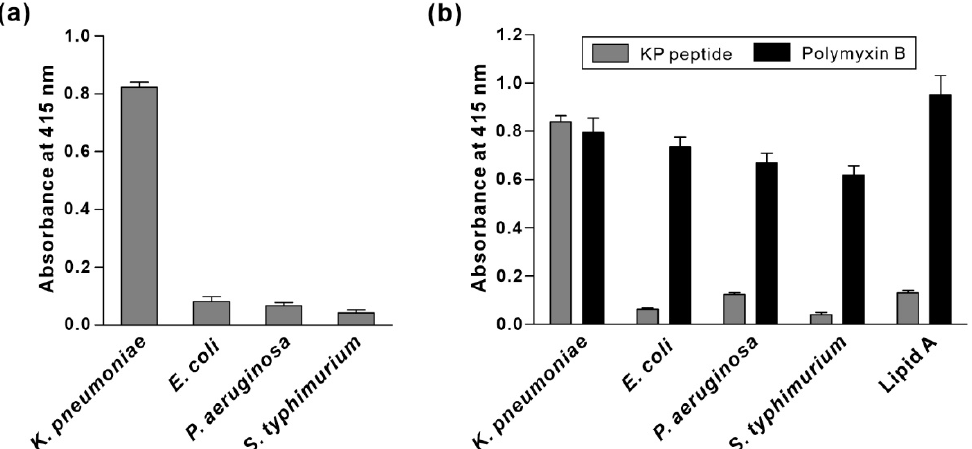
Figure 5. Validation of binding activity of KP peptide to LPS. The binding of KP peptide to LPS from K. pneumoniae and their cross binding to LPS from the other Gram-negative bacteria were determined by peptide-binding ELISA. Extracted LPS ( a ), commercially available LPS, and lipid A ( b ) were coated onto microtiter plates. Peptides (biotinylated KP peptide and polymyxin B) bound to the coated LPS were detected by HRP-conjugated streptavidin and the substrate ABTS. The data are presented as the mean ± SD of three independent experiments performed in triplicate.